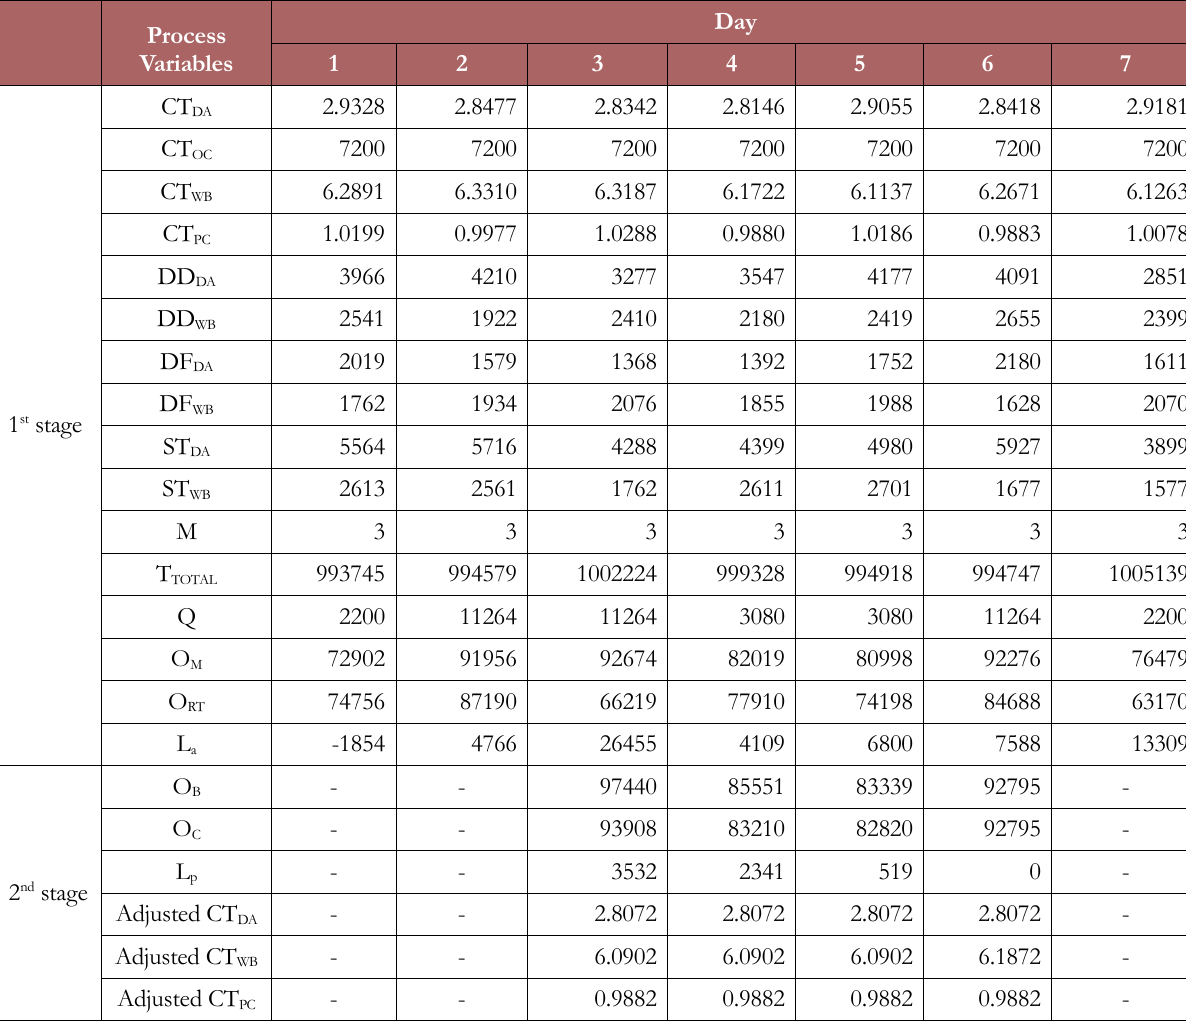
Table 4. 1 st Stage and 2 nd Stage of Production Planning for 3 rd